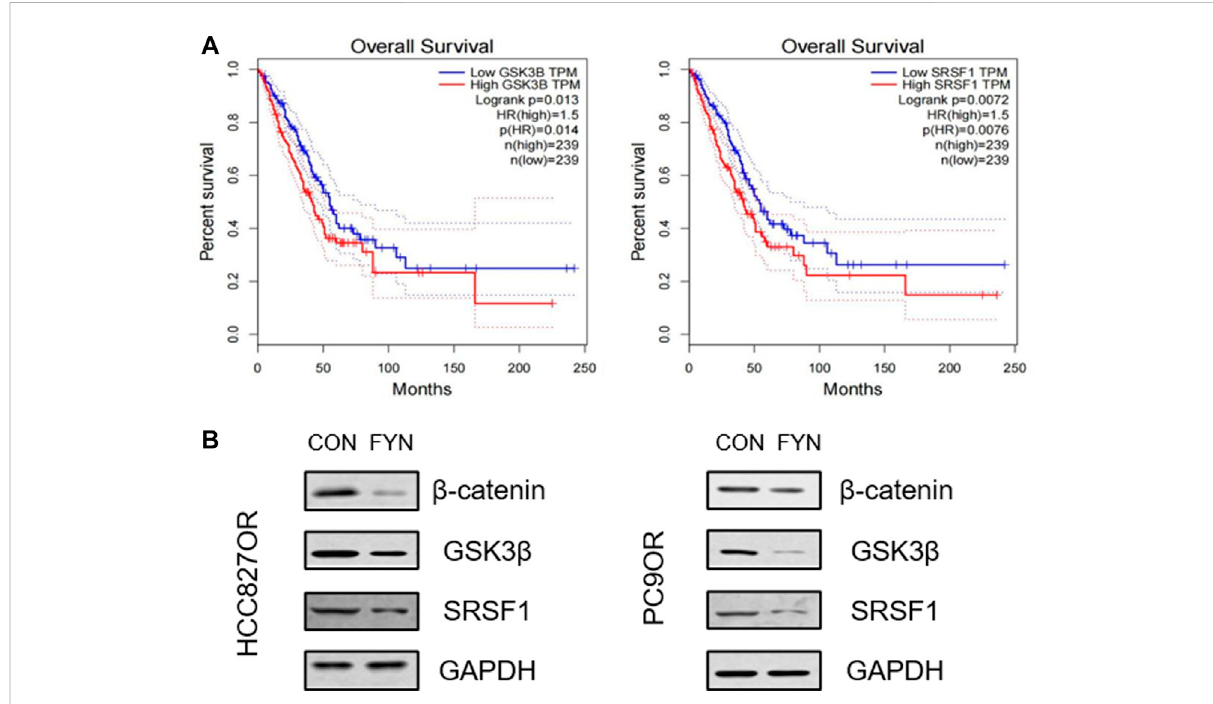
FIGURE 5 FYN reduced SRSF1, GSK3 β , and β -catenin protein levels. (A) Correlations between overall survival in LUAD patients and GSK3 β and SRSF1 expression, analyzed using the GEPIA website. (B) HCC827OR cells were treated with FYN at IC 50 or isovolumetric 1640 medium for 48 h for analysis. Protein levels of SRSF1, GSK3B, and β -catenin were determined by western blotting. Con, control; FYN, Feiyanning